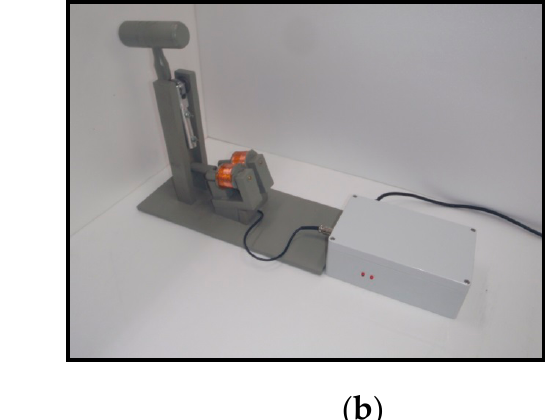
Figure 4. Experimental setup of the oscillating impact device: ( a ) physical system; ( b ) impacting force.